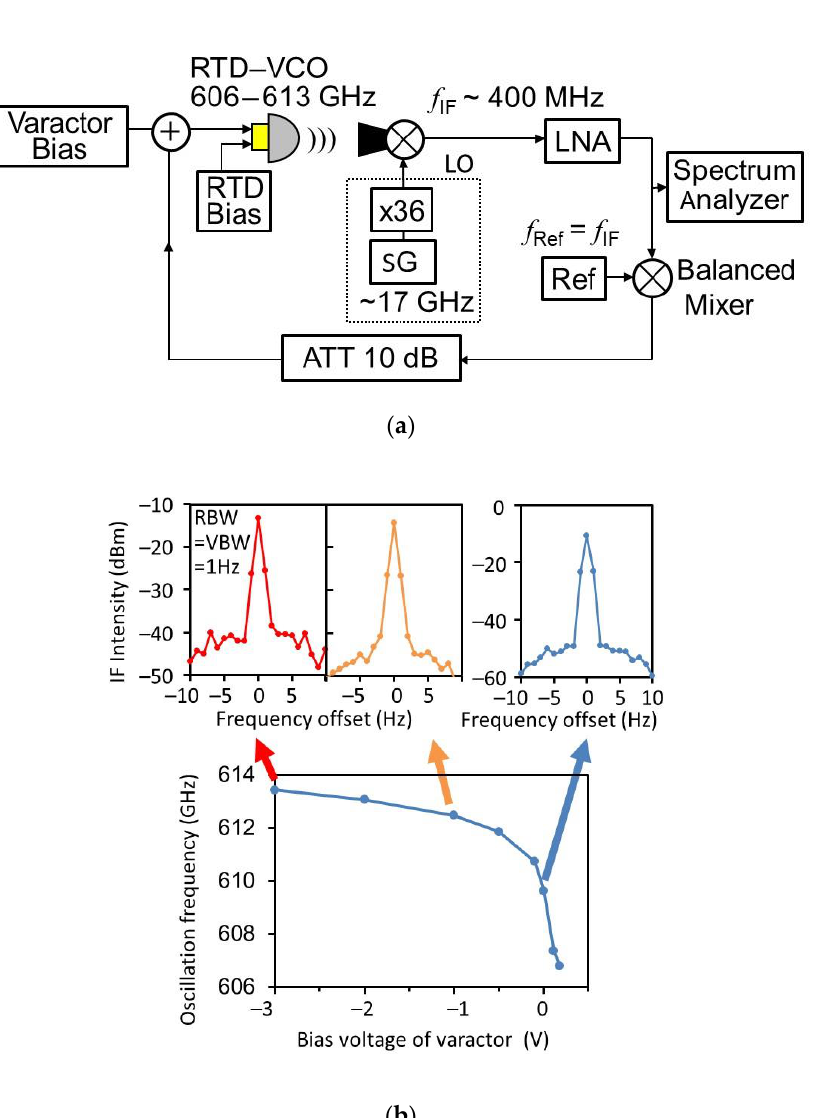
Figure 10. Phase-locked loop (PLL) system and spectral narrowing of frequency-tunable RTD oscillator. Copyright (2018) The IEICE of Japan [93]: ( a ) Block diagram of the PLL system—LNA: low-noise amplifier, ATT: attenuator, SG: signal generator, and ( b ) oscillation spectra under the PLL at various oscillation frequencies—RBW: resolution band width, VBW: video band